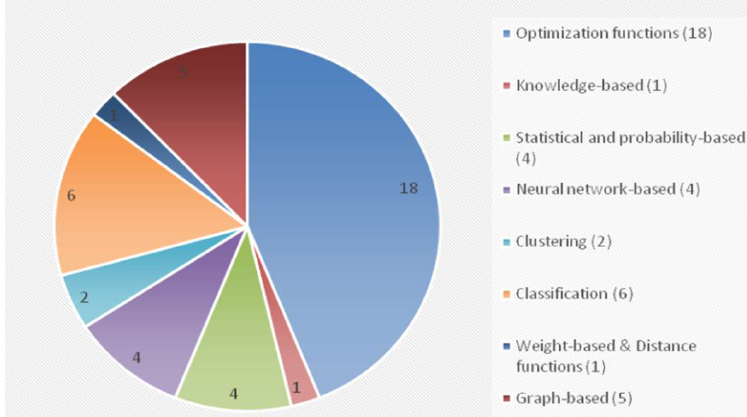
Figure 7. Approaches used in real-time bidding (RTB) and ad scheduling.